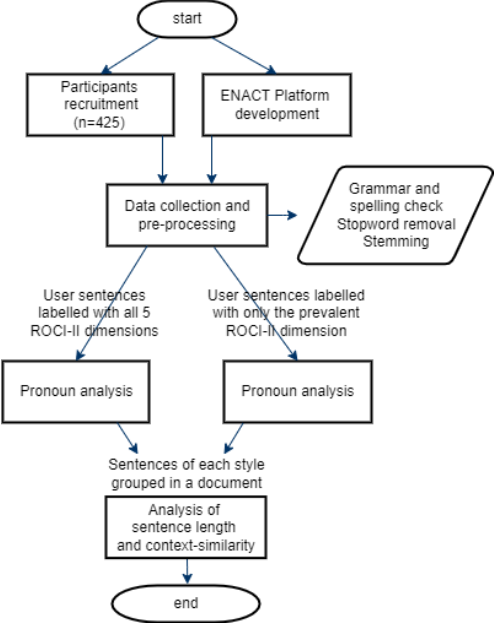
Figure 1. Flow diagram of the